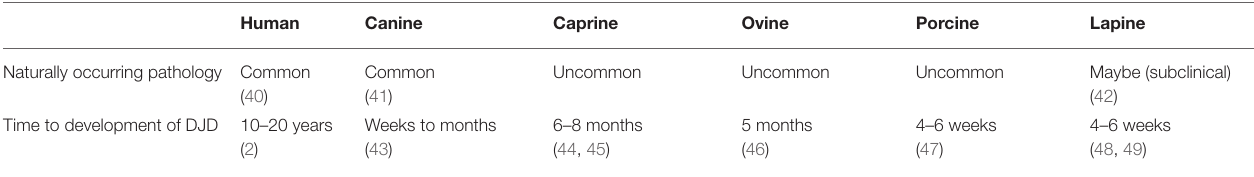
TABLE 2 | Comparison of pathologic characteristics between humans and large animal